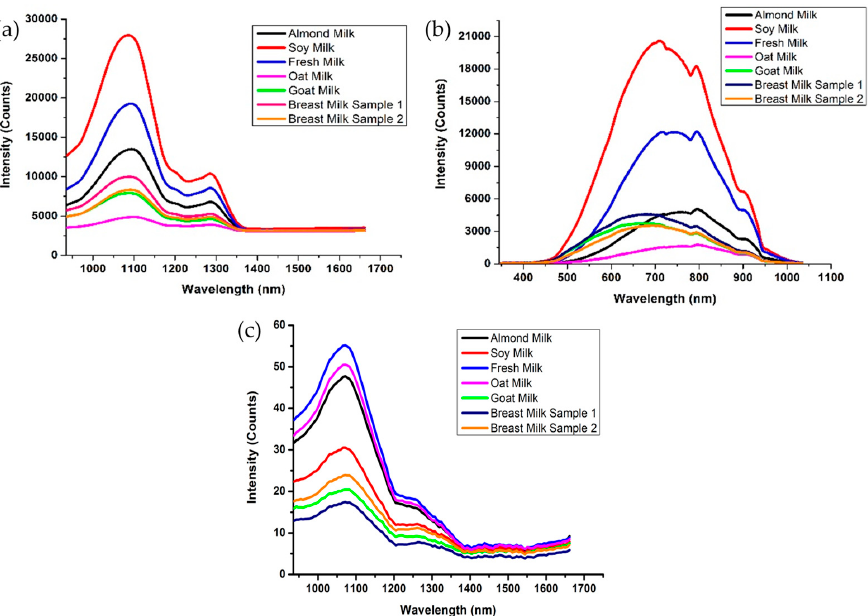
Figure 2. The spectra of various types of milk samples: ( a ) absorbance spectra through NIR spectrometer, ( b ) absorbance spectra through VIS-NIR spectrometer and ( c ) fluorescence spectra through NIR spectrometer.